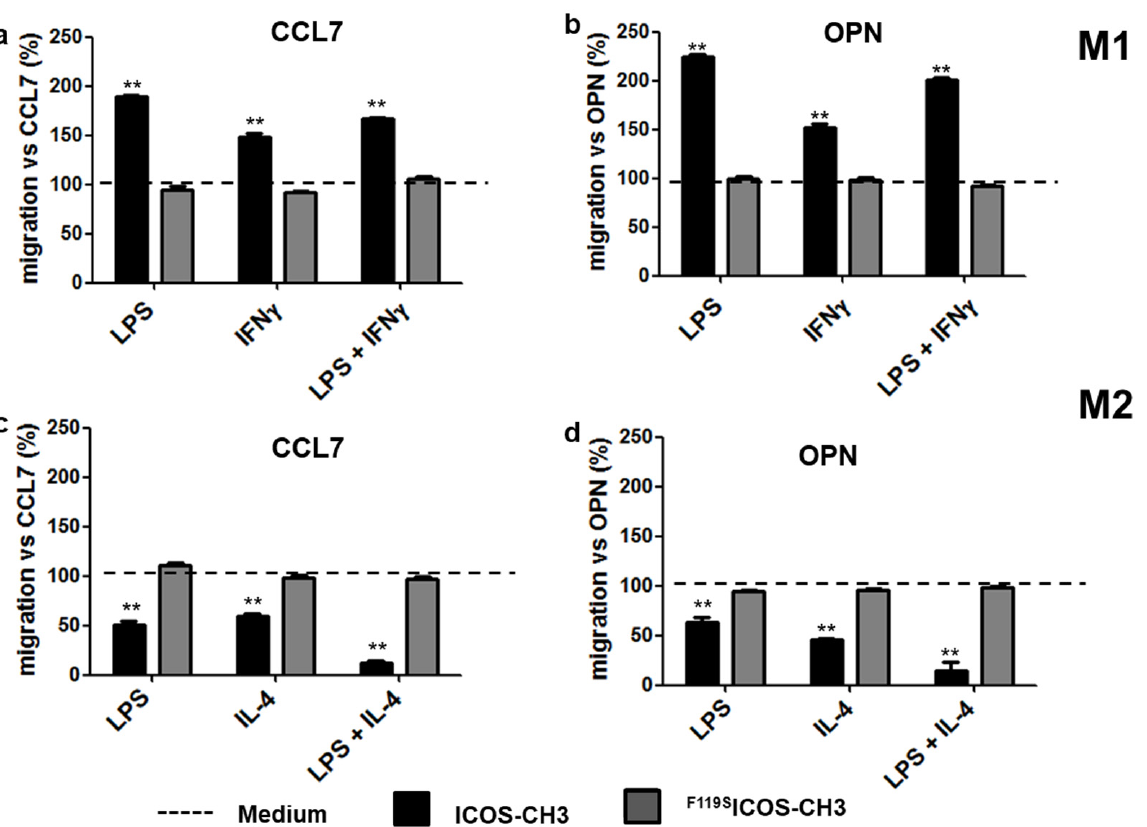
Figure 5. Effect of ICOS-CH3 on M1 and M2 cell migration. ( a , b ) M1 MDMs were treated with LPS, IFN γ , or LPS + IFN γ and ( c , d ) M2 MDMs with LPS, IL-4, or LPS + IL-4. Cells were plated on the